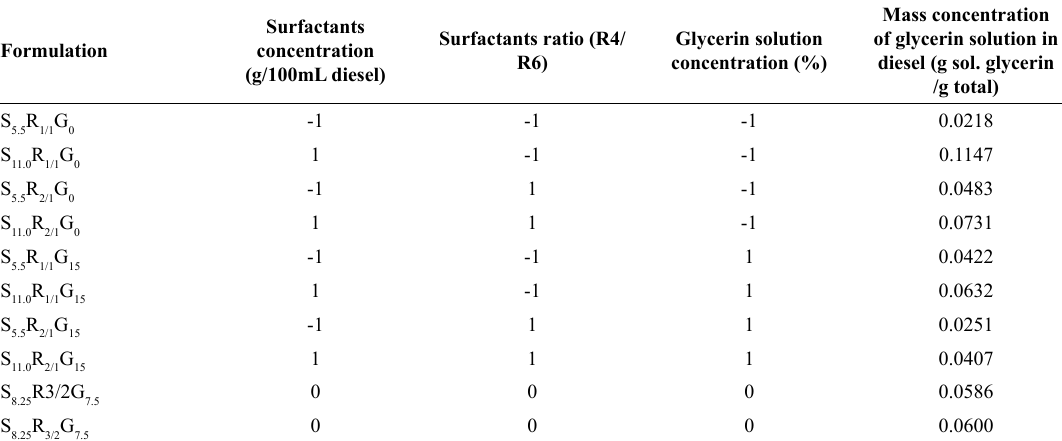
Table 4. Solubility of the micro emulsified fuels and their names.